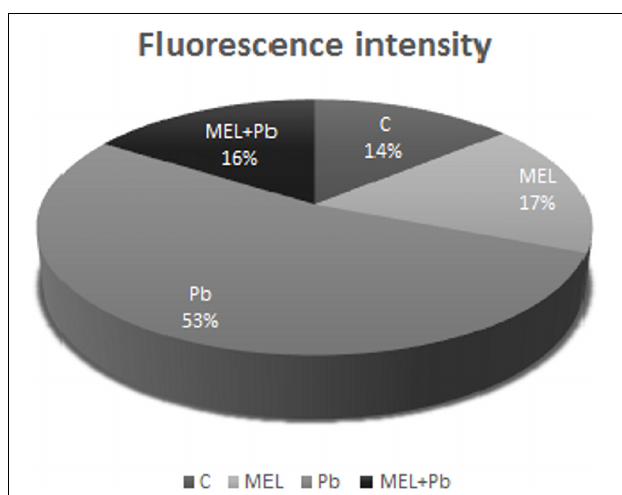
FIGURE 3 | The fluorescence intensity of nuclear chromatin stained with AO/EB 4 h after lead administration. C, BY-2 cells cultured on LS medium – the control variant; MEL, BY-2 cells cultured on LS medium with 200 nM melatonin added from the beginning of culture; Pb, BY-2 cells cultured on LS medium with 15 µ M Pb 2 + added on the 4th day of culture and MEL + Pb, BY-2 cells cultured on LS medium with melatonin added from the start of the culture and with Pb 2 + added on the 4th day of